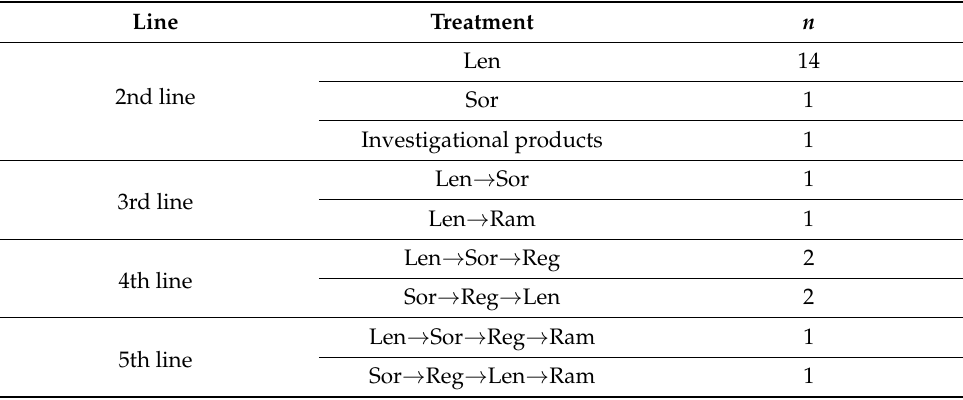
Table 2. Pretreatment of patients with a history of systemic